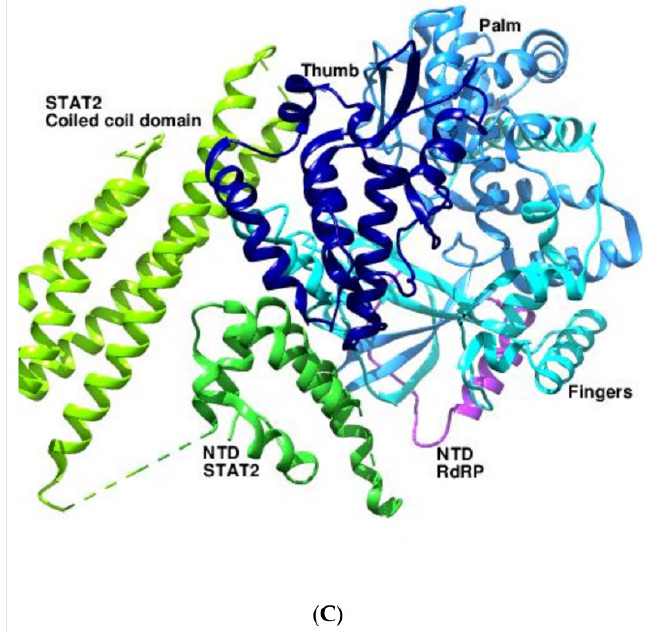
Figure 3. RTCs of SARS-CoV-2. ( A ) RdRP (light blue), nsp7 (green), nsp8 (purple), nsp13 (Dodger blue), template (yellow), and product (orange) RNA are shown in surface representation. The positively charged tentacle-like amino-terminal extensions of the two nsp8 copies can be seen clasping the RdRP. The disposition of the nsp12 with respect to the other domains indicates its extensive interaction with the RTC. ( B ) The complex of the nsp9 with the RTC is shown. The interaction of the NiRAN domain (1-385, cyan) with the nsp9 (red surface) is implicated as one of the first steps in the capping of the 5 (cid:48) genomic RNA. ( C ) The NTD of STAT2 (1-136, dark green) interacts with the residues 314-327 of the fingers subdomain (305-495, navy blue), while the coiled-coil domain of STAT2 (137-315, lime green) interacts with residues 847-855 of the thumb subdomain (721-888, Dodger blue). The NTD (273-307, purple), and the palm (496-720, cyan) subdomains of RdRP are